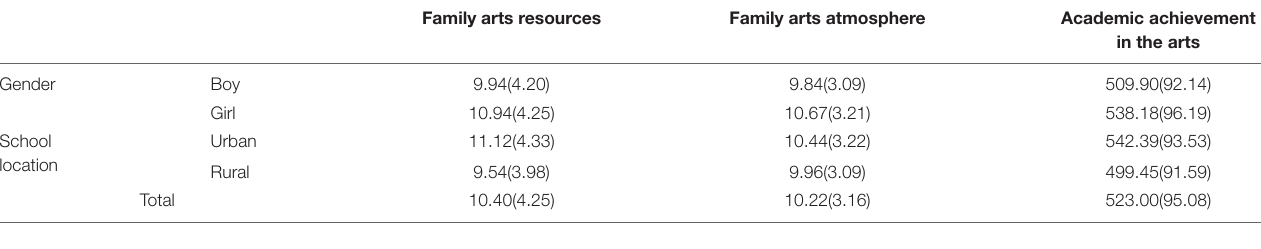
TABLE 1 | Descriptive statistics (means and standard deviations) among gender and school location.